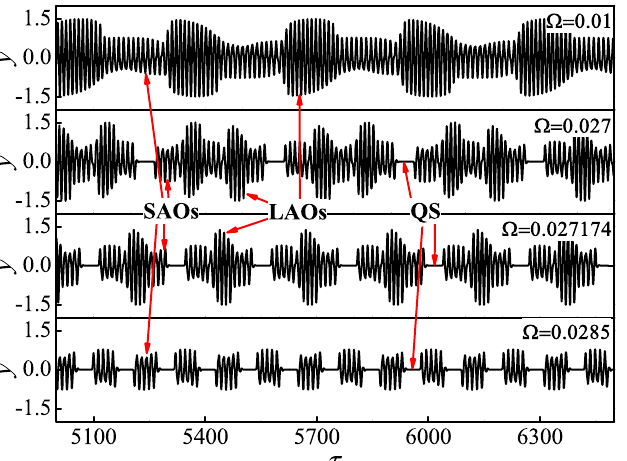
Figure 2. Time histories of four responses of whole system (3) corresponding to a different excitation frequency Ω